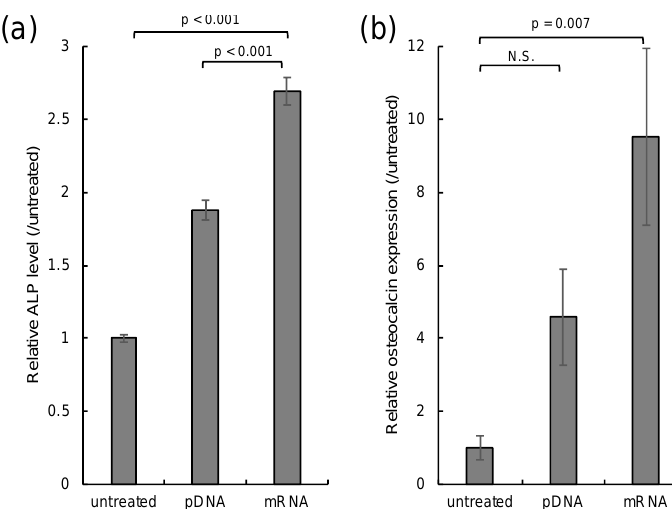
Figure 4. In vitro osteogenic differentiation. MSC spheroids were transfected with Runx2 mRNA and pDNA four times every 3 days. Spheroids without transfection were used as a control (untreated). ( a ) Enzymatic activity of ALP 14 days after the first transfection. n = 6. ( b ) Osteocalcin transcript level 21 days after the first transfection. n = 5. Data are presented as mean ± standard error of the mean. Statistical analysis was performed by analysis of variance (ANOVA), followed by Tukey’s test.